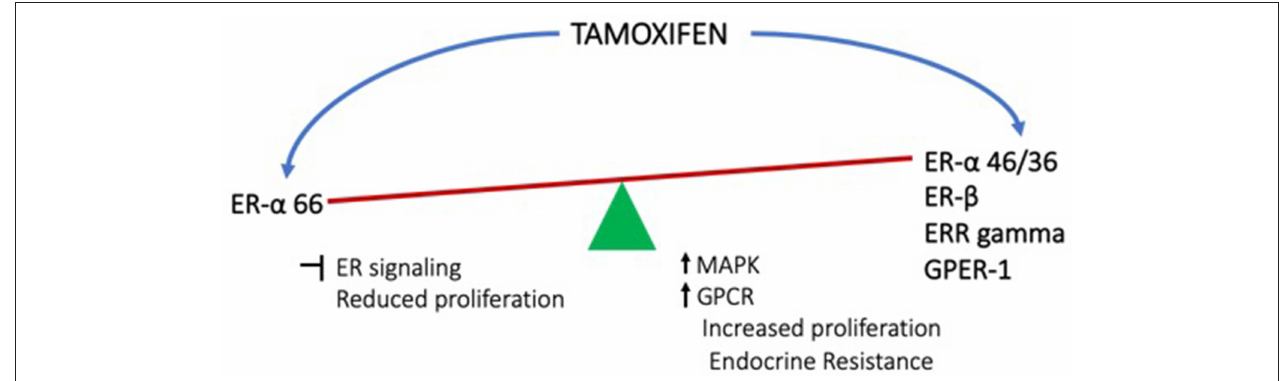
FIGURE 2 | Effects of tamoxifen (endocrine therapy) on the conventional estrogen signaling from ER- α and the non-canonical signaling from other receptors.